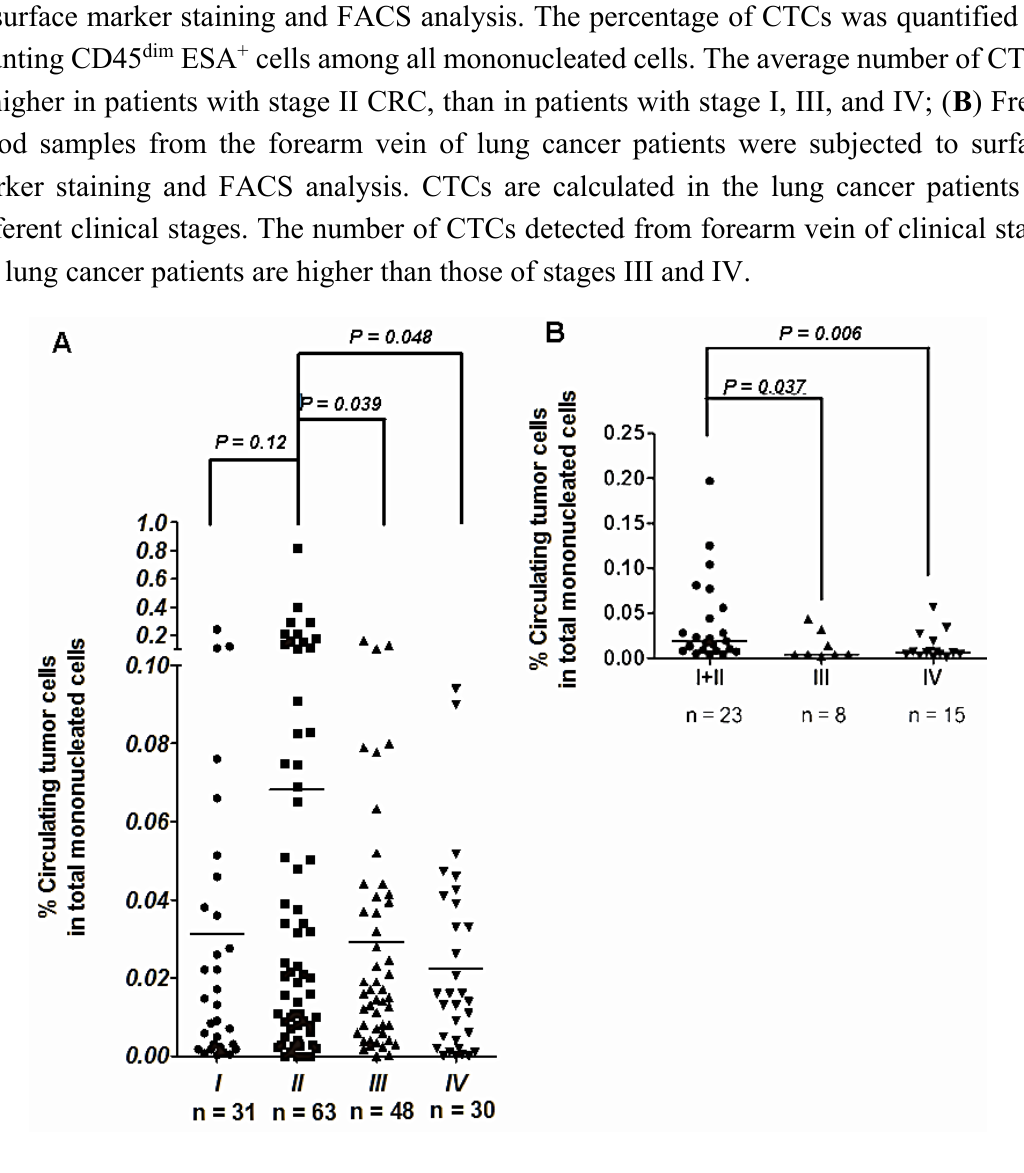
Figure 1. The number of circulating tumor cells in CRC and lung cancer patients ( A ) Cells isolated from fresh blood drawn from the mesenteric vein of CRC patients were